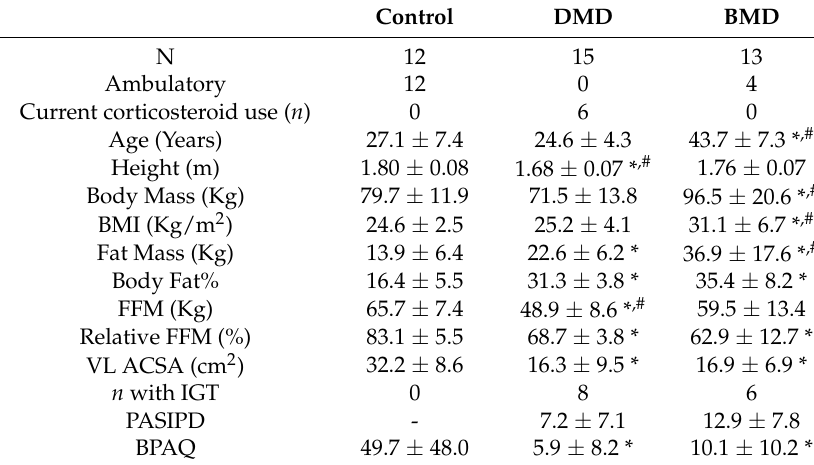
Table 1. Participant characteristics and anthropometric measurements from adult males with (DMD and BMD) and without (Control) muscular dystrophy